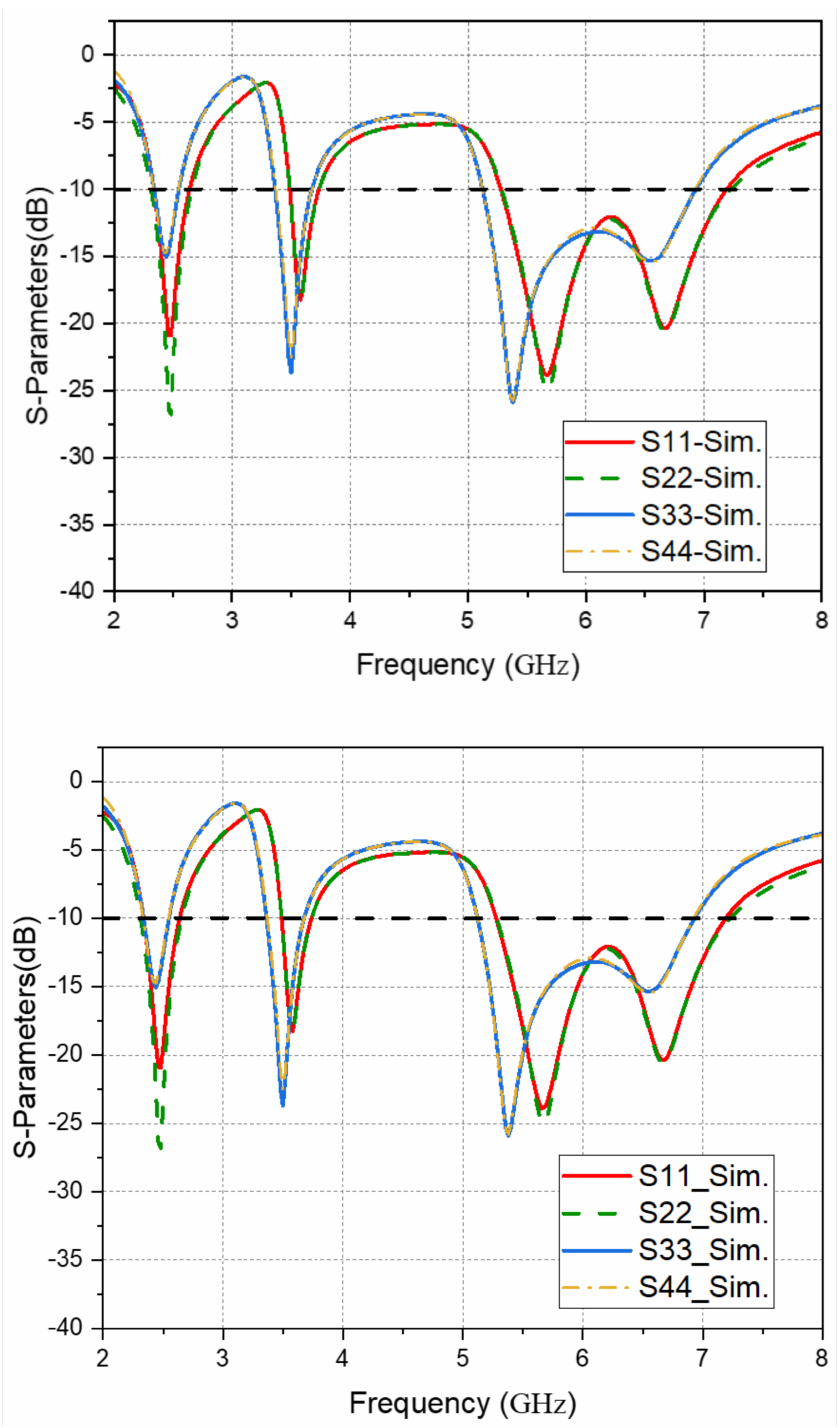
Figure 12. Reflection coefficients for the final proposed size of the antenna system (|S11|, |S22|, |S33|,